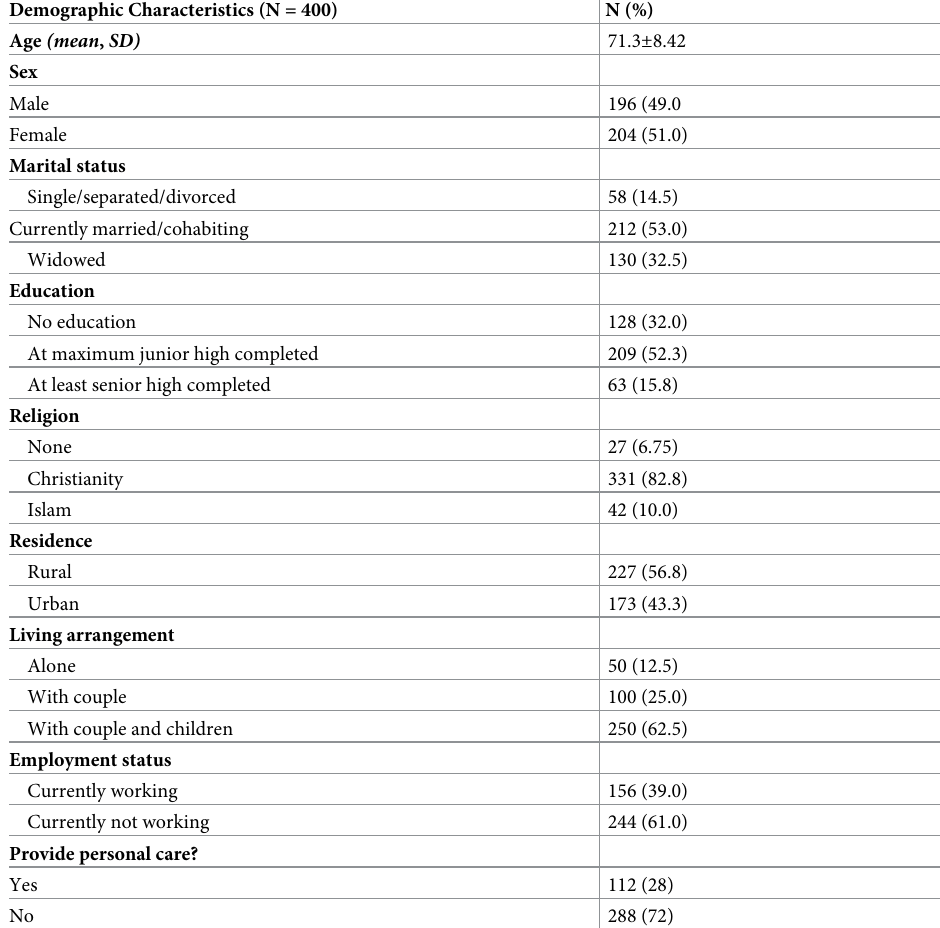
Table 1. Socio-demographic characteristics of